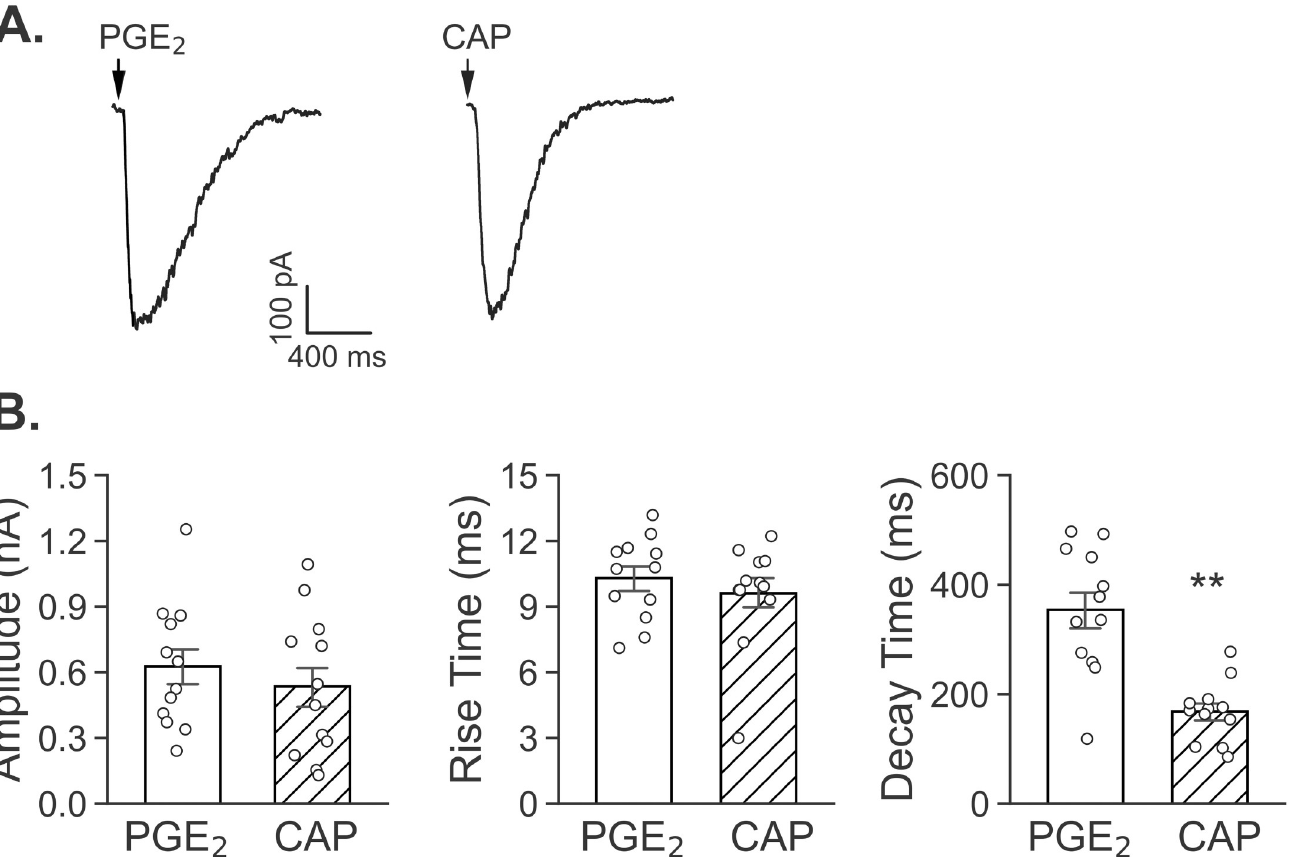
Fig 4. Kinetic characteristics of CAP- and PGE 2 -induced currents in two groups of vagal pulmonary C-neurons. The amplitudes and 10–90% rise times did not have a significant difference between these two currents, while the decay time of PGE 2 -induced currents were 2-fold longer than that of CAP-induced currents. n = 12 neurons in the two groups respectively. In our patch clamp studies, “n” represents numbers of the neurons tested. �� P < 0.01, compared to CAP-induced currents.